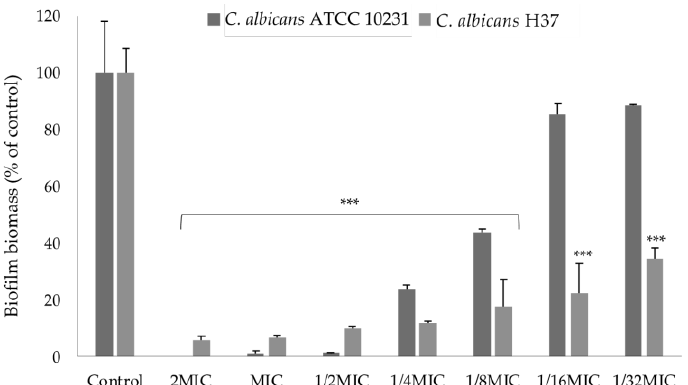
Figure 3. Percentage of biofilm formation by two Candida albicans strains (ATCC 10231 and H37) with different concentrations of compound 1 . Data are shown as mean ± standard deviation of at least three independent assays. Control included an appropriate concentration of dimethylsulfox- ide. MIC: Minimal inhibitory concentration. *** p < 0.001 (one-way ANOVA followed by Dunnett´s test).